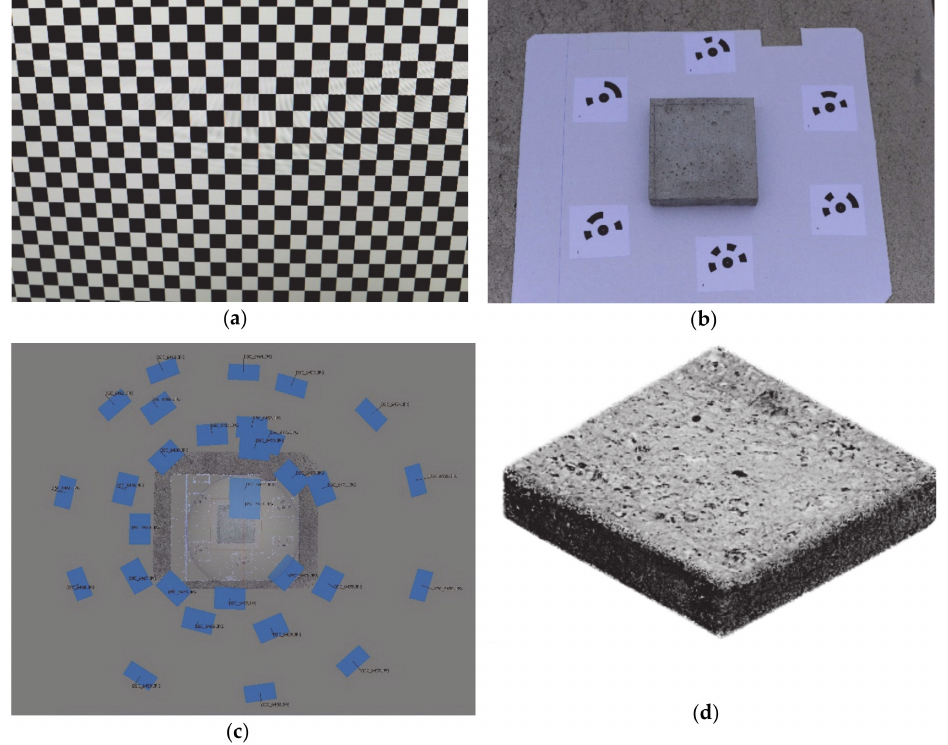
Figure 7. Stages of close-range photogrammetry (CRP) model preparation: ( a ) black and white chessboard for camera calibration; ( b ) a sample on the stand with markers (six coded control points); ( c ) estimated locations of the camera (blue rectangles); ( d ) dense point cloud obtained for the concrete